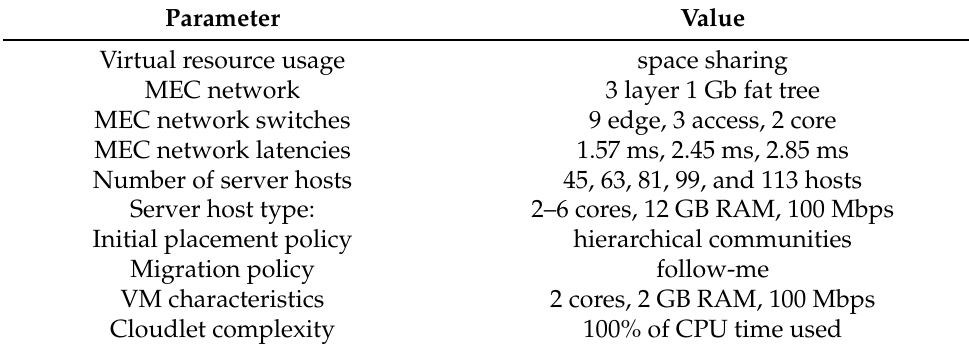
Table 2. CloudSim simulation